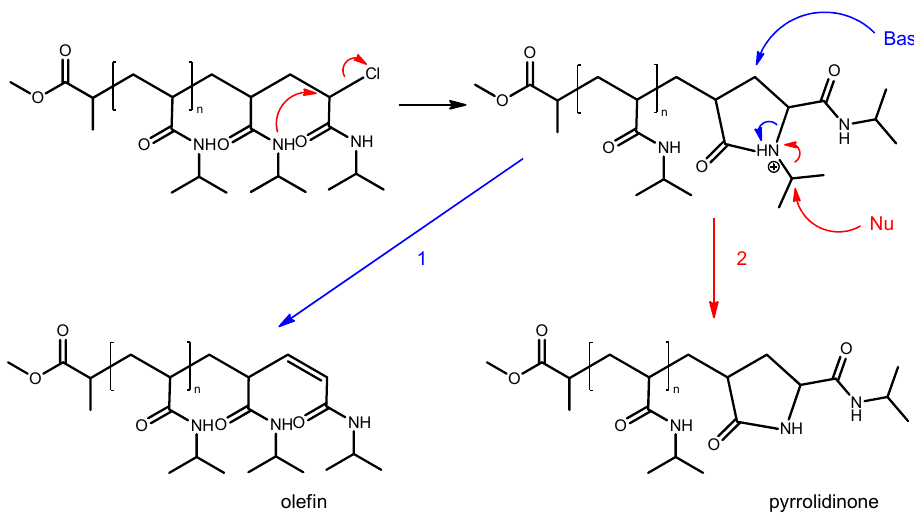
Figure 3. Formation of the unsaturated and pyrrolidinone-based ω chain end group.